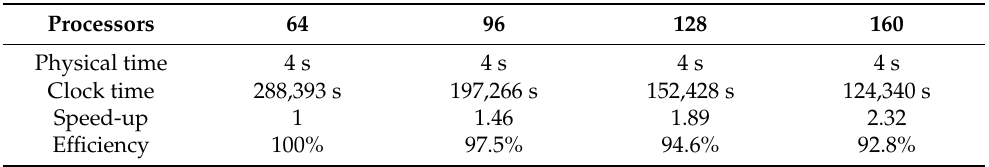
Table 4. Efficiency of OpenFOAM parallelization for a test case of the Canadian ship A at headwind with 43.4 million cells.